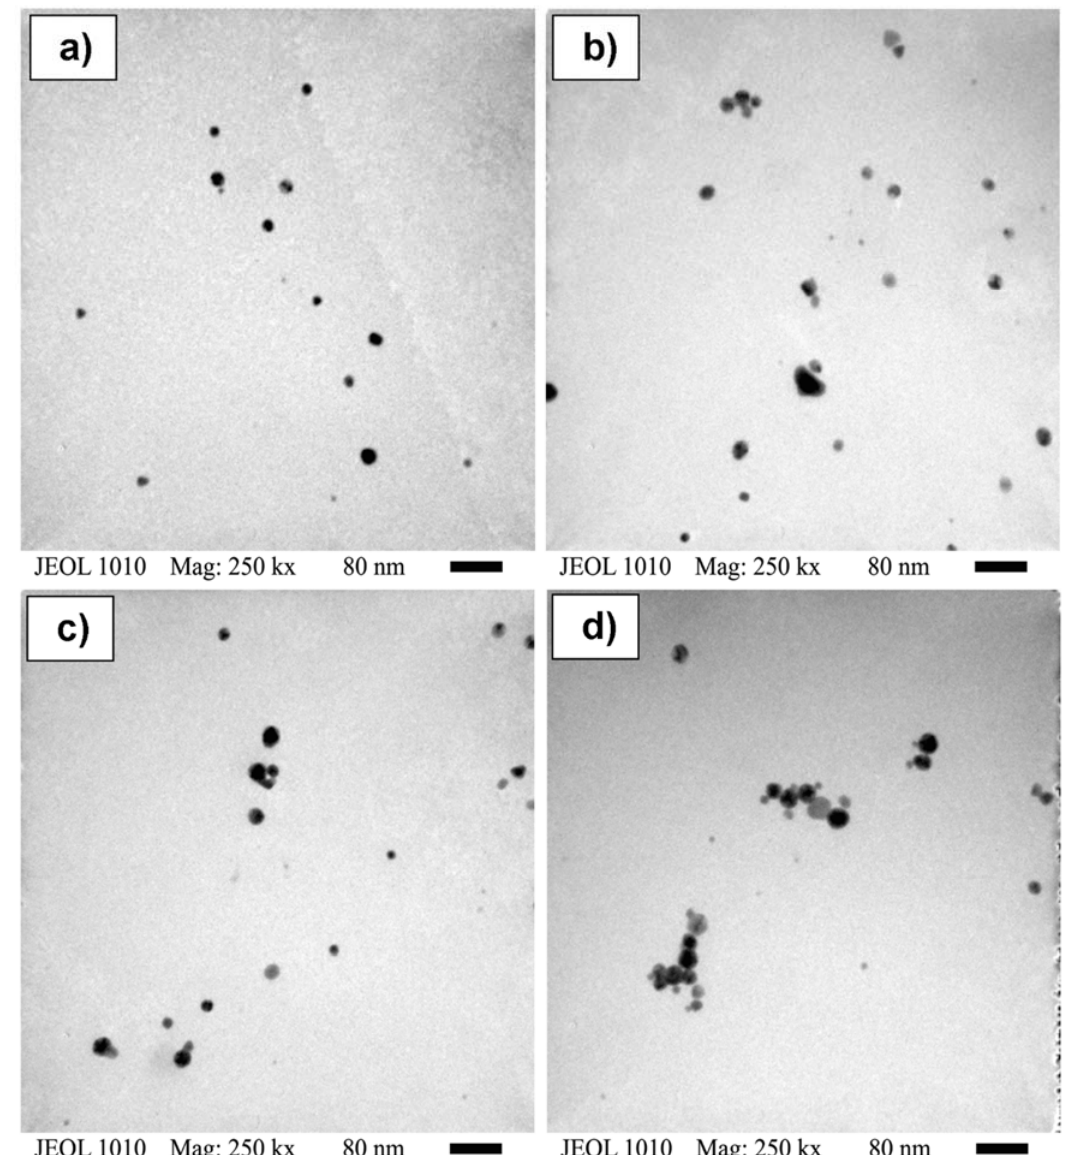
Figure5. PhotographsofAuNPsobtainedbyTEMatthedi ff erentconcentrationsofHAuCl 4 · 3H 2 O(mM): Figure 5. Photographs of AuNPs obtained by TEM at the different concentrations of HAuCl 4 ∙ 3H 2 O ( a ) 0.4, ( b ) 0.7, ( c ) 1.0 and ( d ) (mM): ( a ) 0.4, ( b ) 0.7, ( c ) 1.0 and ( d ) 1.3.